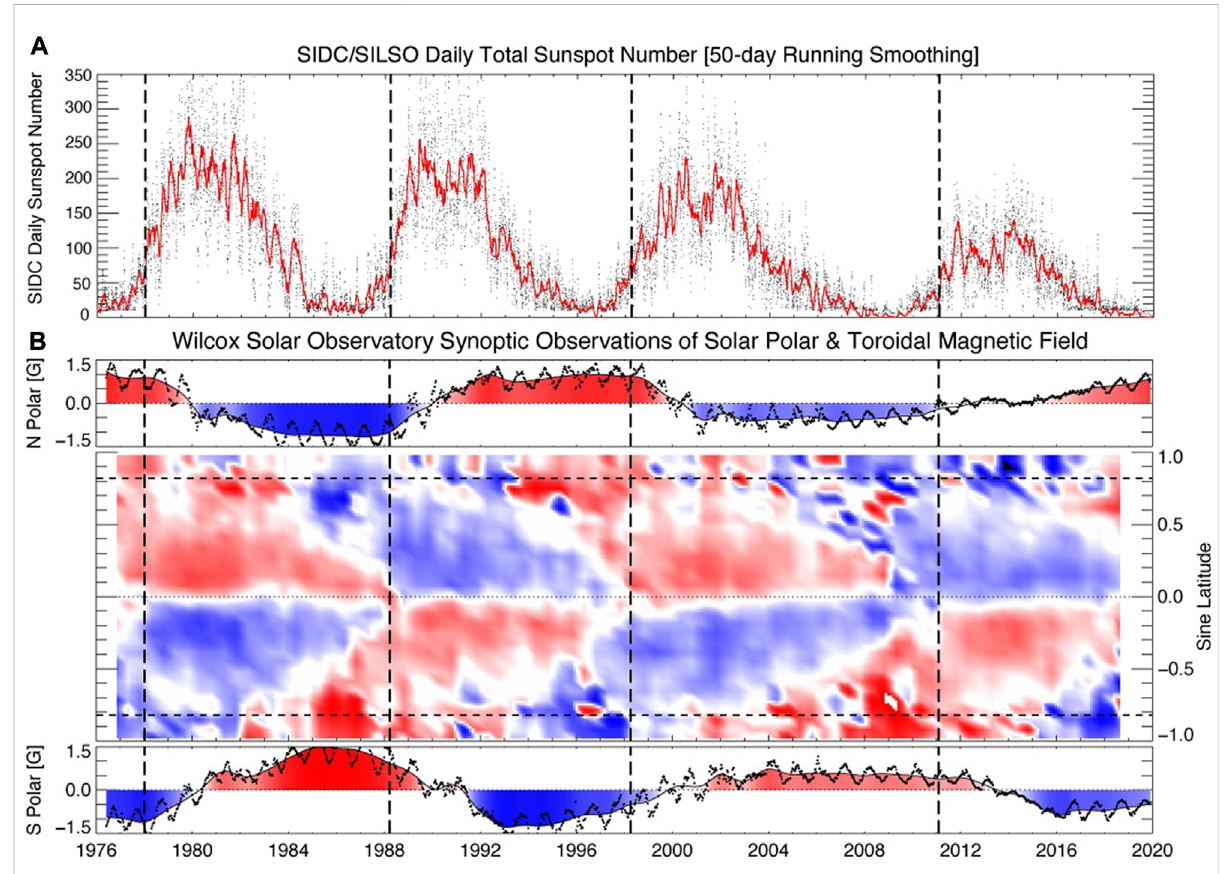
FIGURE 2 WSO Inferred toroidal magnetic fi eld evolution since 1976. Comparing and contrasting the evolution of the total sunspot number [panel (A) ], with the spatio-temporal distribution of the derived toroidal magnetic fi eld component (central) and polar magnetic fi eld components (above north andbelowsouth)derivedfromdailyWSOobservations[panel (B) ].Notethatthetoroidal fi eldpanelisinitsnativesinelatitudeformat(Loetal.,2010). The horizontal dashed lines indicate a latitude of 55 ° while the vertical dashed lines shown in each panel mark the times of the Hale Cycle termination events studied by